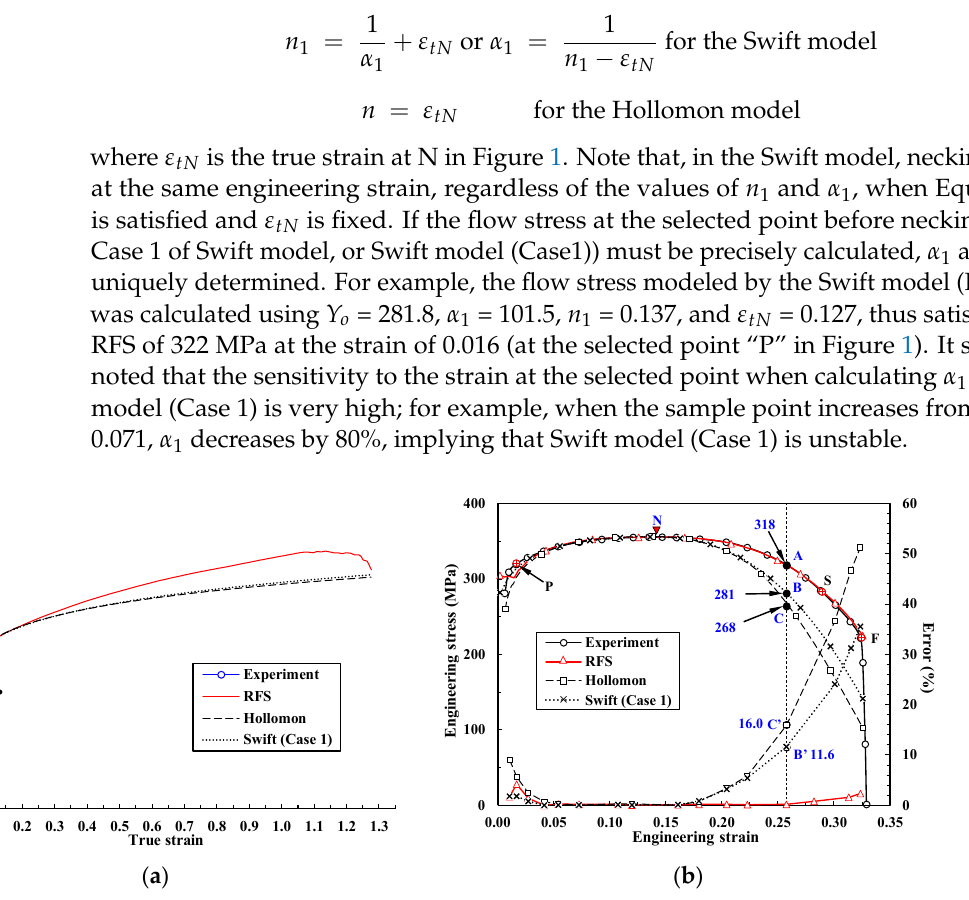
Figure 2. Flow curves of RFS, Swift model (Case 1), and Hollomon model and comparison of their predictions of the tensile test with the experimental tensile test. ( a ) True stress–strain curves; ( b ) engineering stress–strain curves, plotted with error percentage.